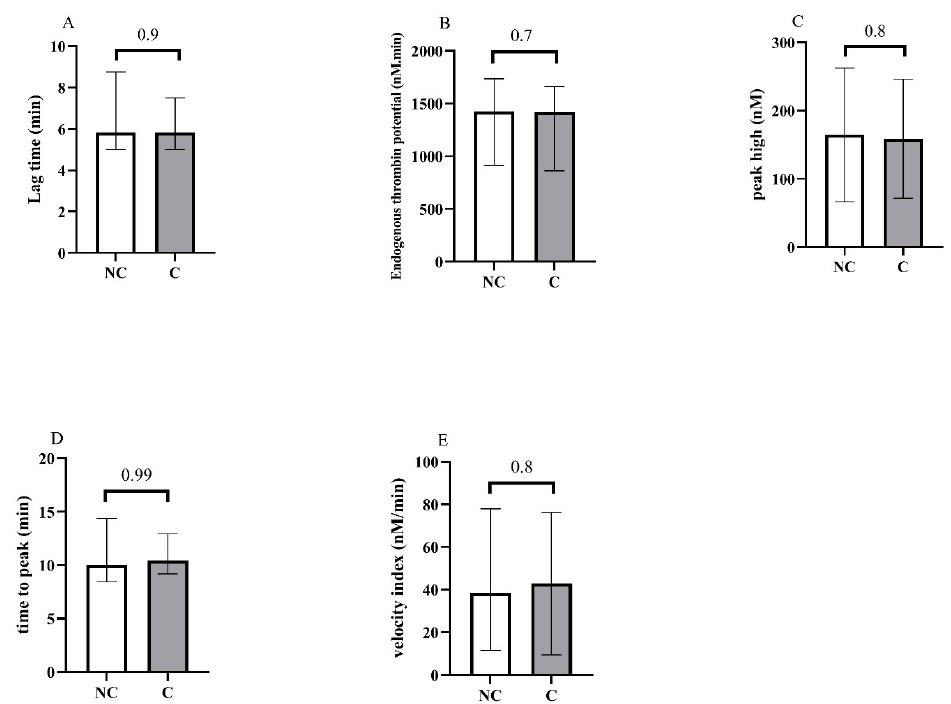
Figure 2. Representation of the thrombin generation assays at the admission of patients in the ICU, and according to non-critical (NC) and critical (C) groups. ( A ) Lag time, ( B ) endogenous thrombin potential, ( C ) peak high, ( D ) time to peak, ( E ) velocity. VET profiles showed a pro-coagulant state in COVID-19 patients versus “control” patients, with shorter clotting times and stronger clot stiffness, fibrinogen and platelet contributions. No difference was observed between “critical and non-critical groups (Table 4). Table 4. Viscoelastic tests of COVID-19 patients and control patients.